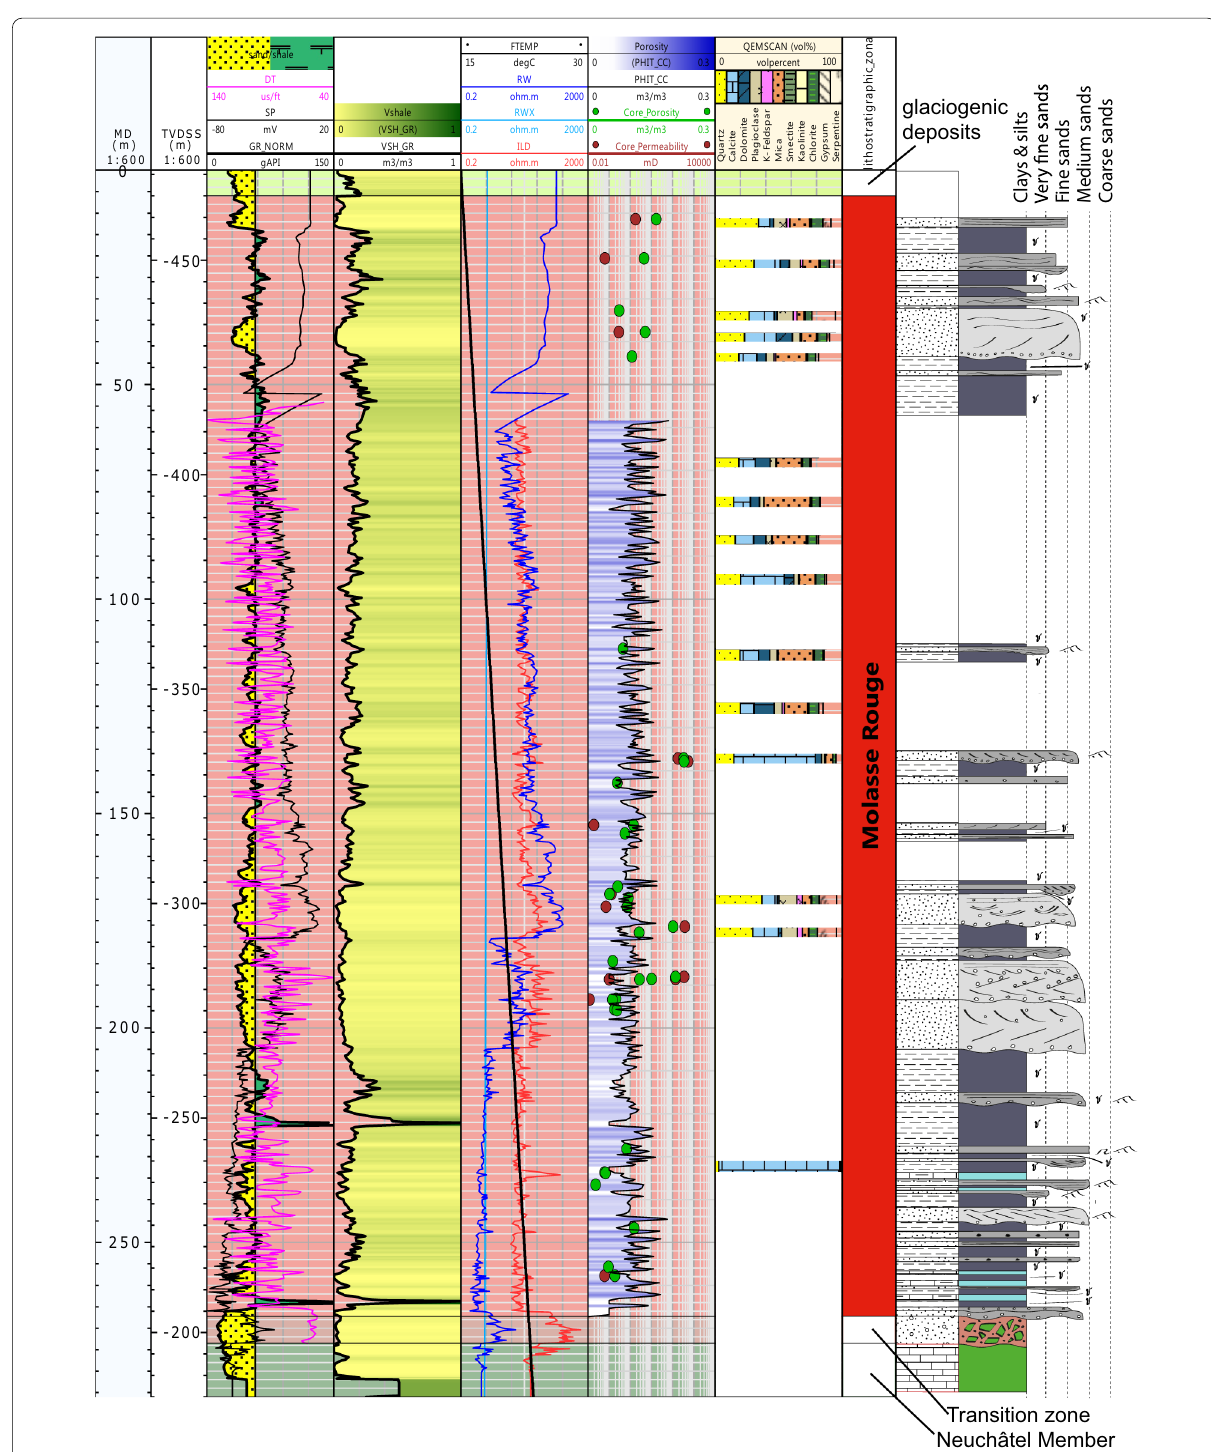
Fig. 3 Methodological approach depicting petrophysical calculations with revised stratigraphic log, associated geophysical well-logs and mineralogical laboratory results for well Gex-CD-01. White areas in QEMSCAN column represent no measurements. Note that the minerals illite, biotite and muscovite are summarized under the term “mica”. Remaining space in QEMSCAN column refers to other minerals. MD measured depth (m), TVDSS true vertical depth subsea